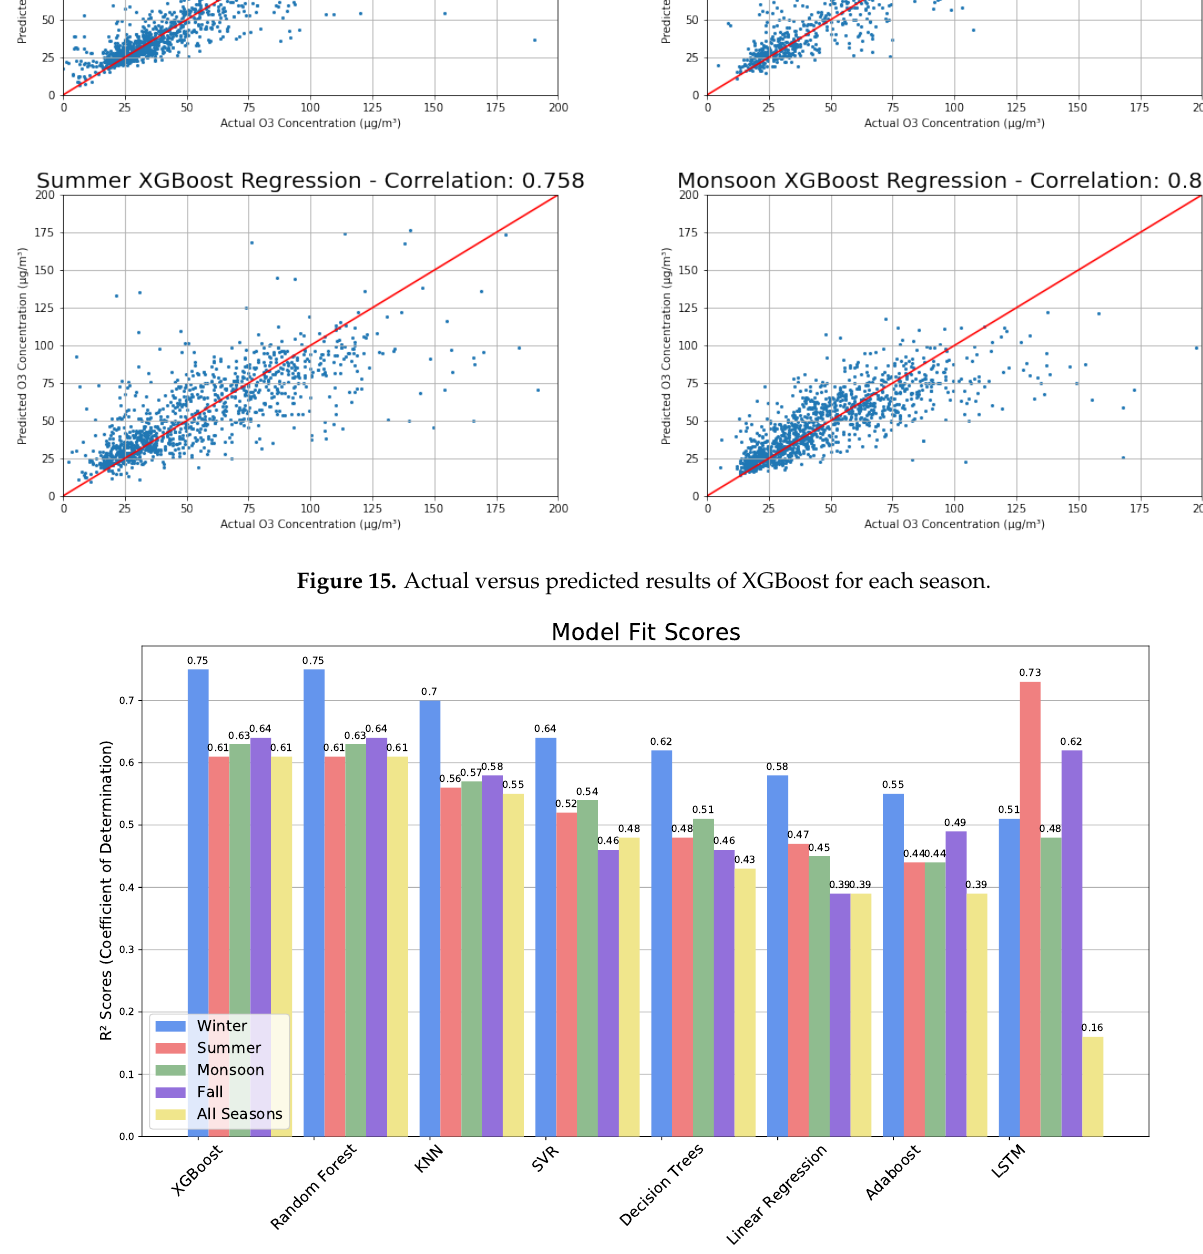
Figure 16. Model fit scores for each season and